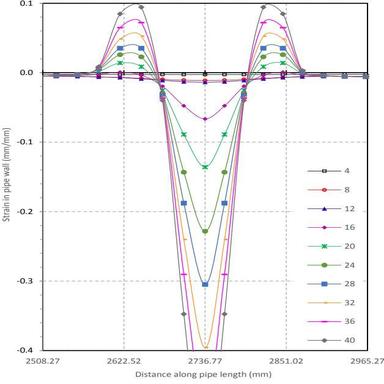
Evolution of strains for half-length pipe model.